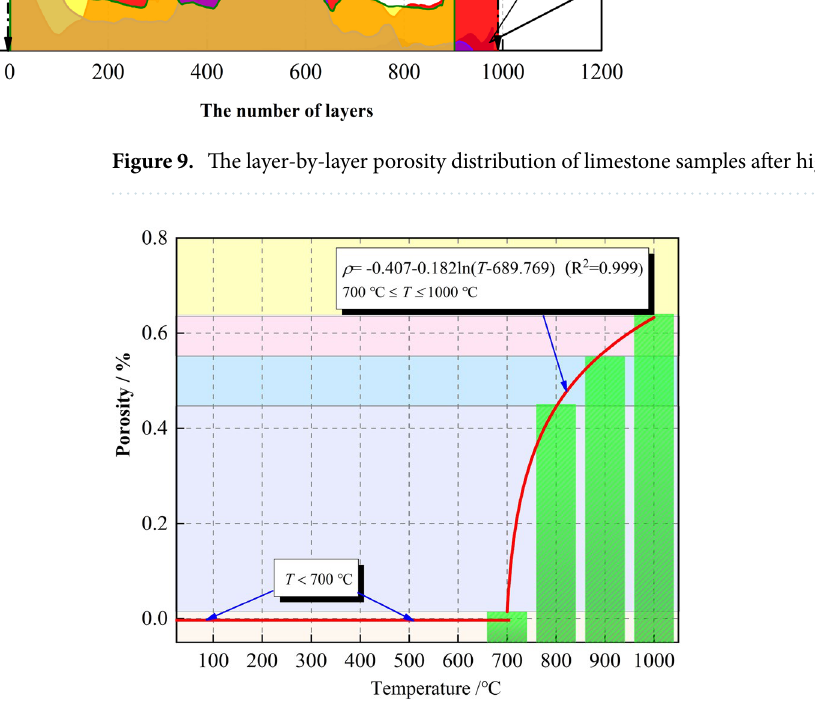
Figure 10. Variation of the porosity of limestone samples with